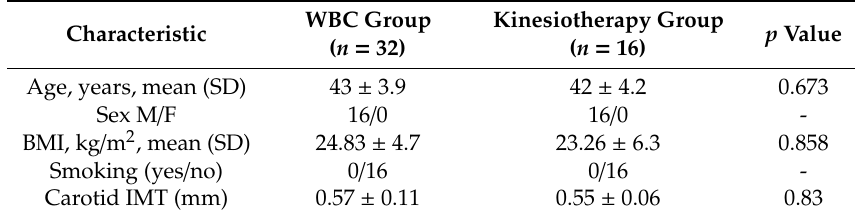
Table 1. Demographic characteristics of the research